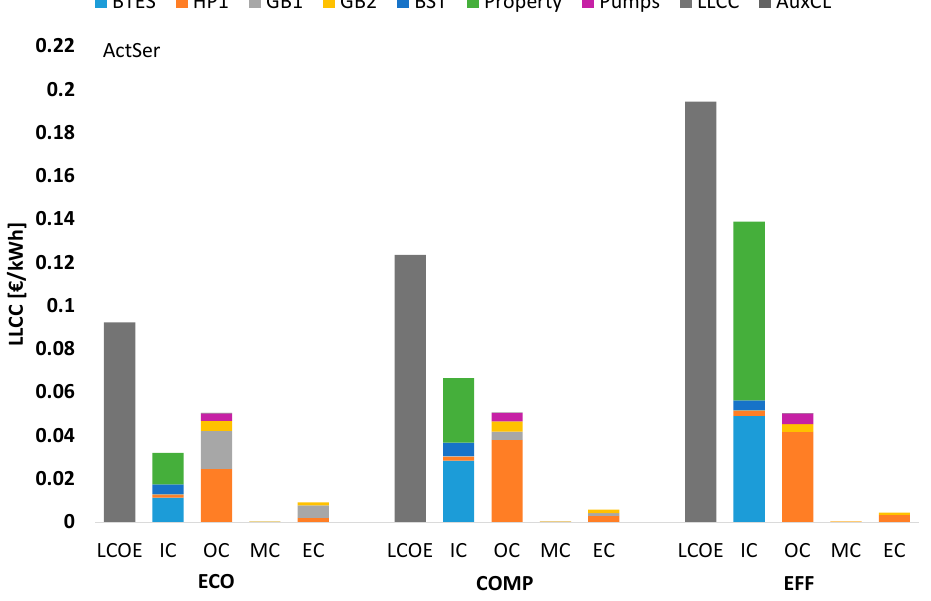
Figure 13. Total and component-wise Levelized Life Cycle Cost (LCOE) of ActSer scenario; LCOE is the summation of Initial Cost (IC), Operational Cost (OC), Maintenance Cost (MC) and Emission Cost (EC) for the economical (ECO), the compromise (COMP) and the most efficient (EFF) designs.